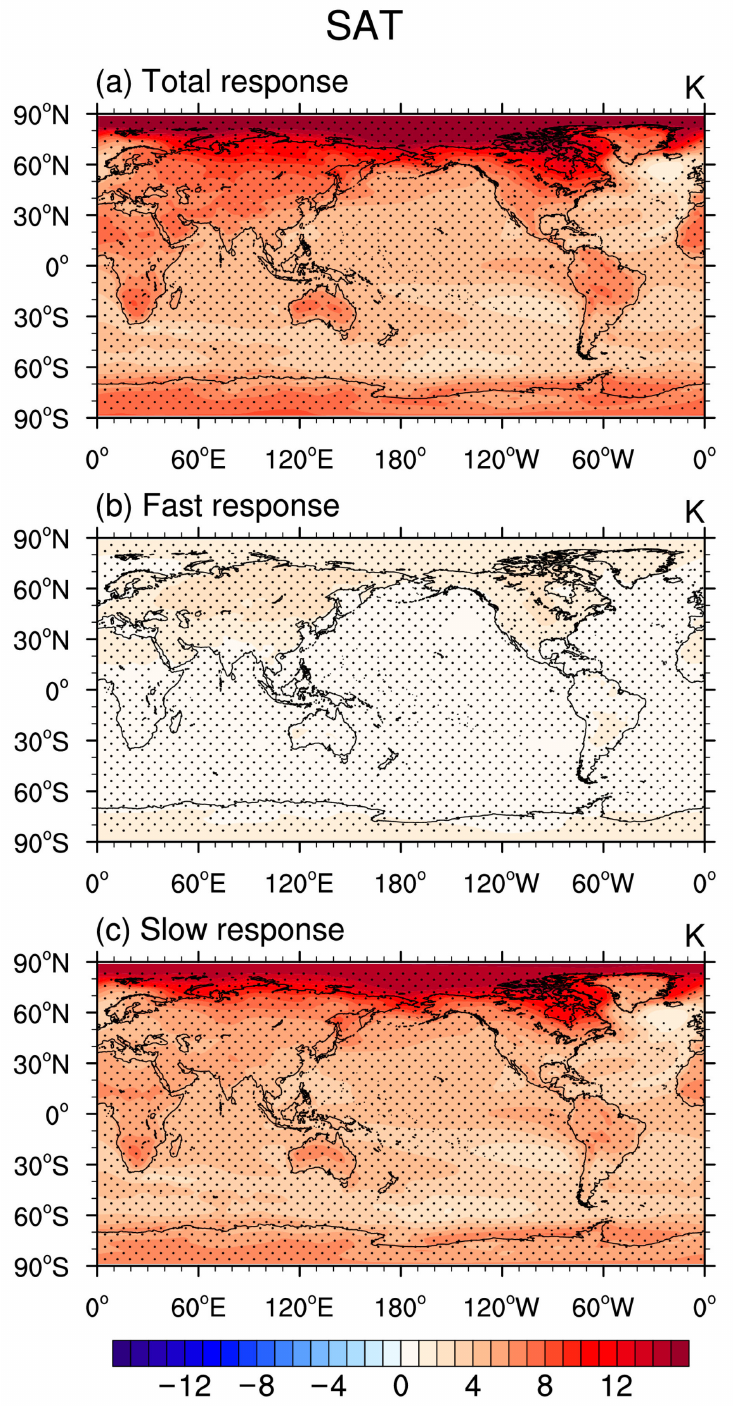
Figure 1. ( a ) Total, ( b ) fast, and ( c ) slow responses of global surface air temperature (units: K). Black dot represents that at least 8 models agree with the sign of